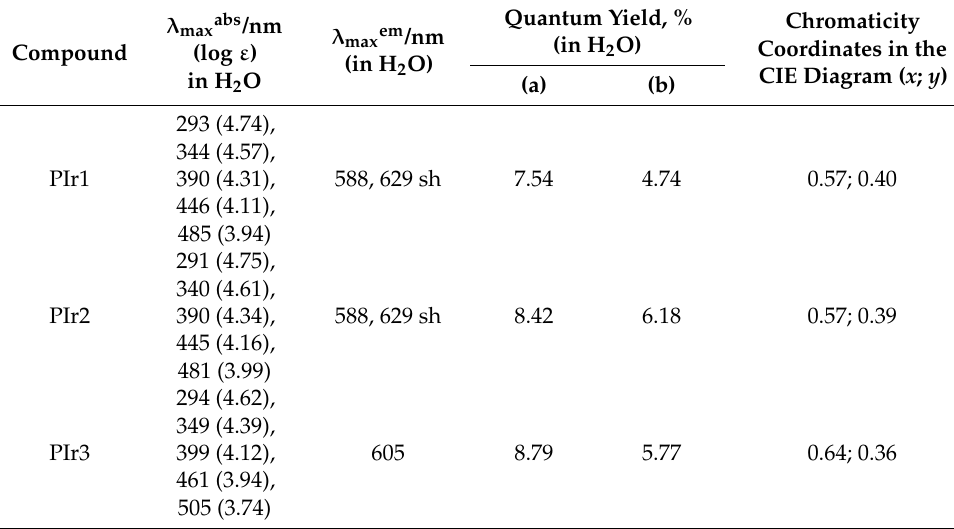
Table 2. Photophysical characteristics of PIr1–PIr3 in H 2 O solution.